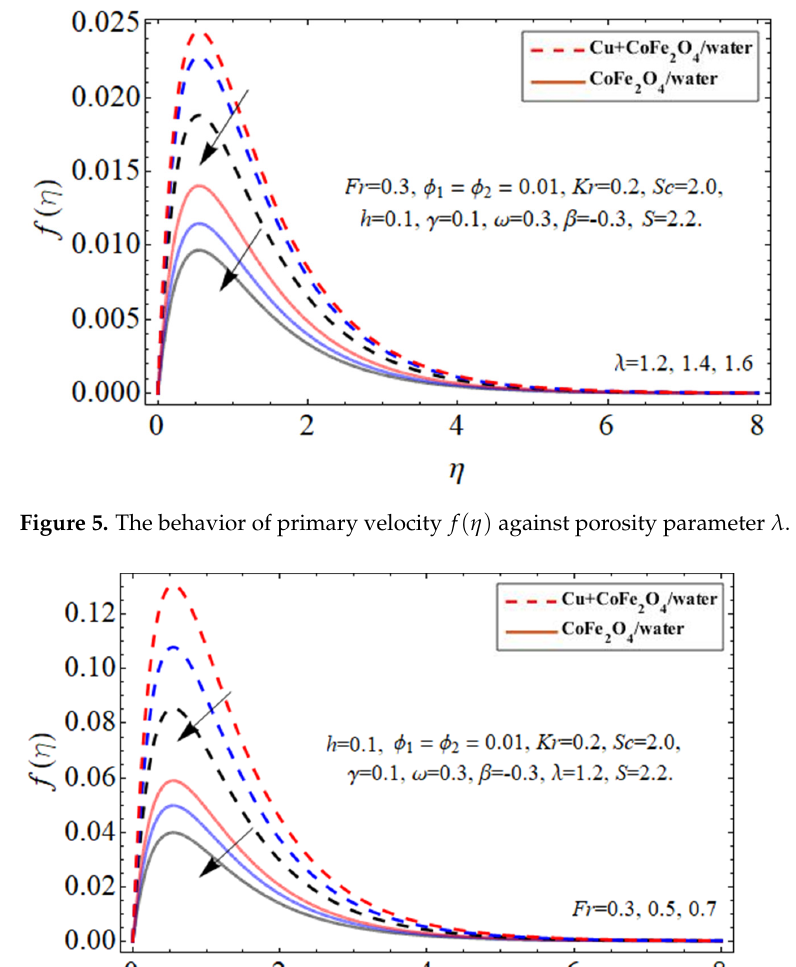
Figure 4. The behavior of primary velocity f ( η ) against disk fluctuation term S .